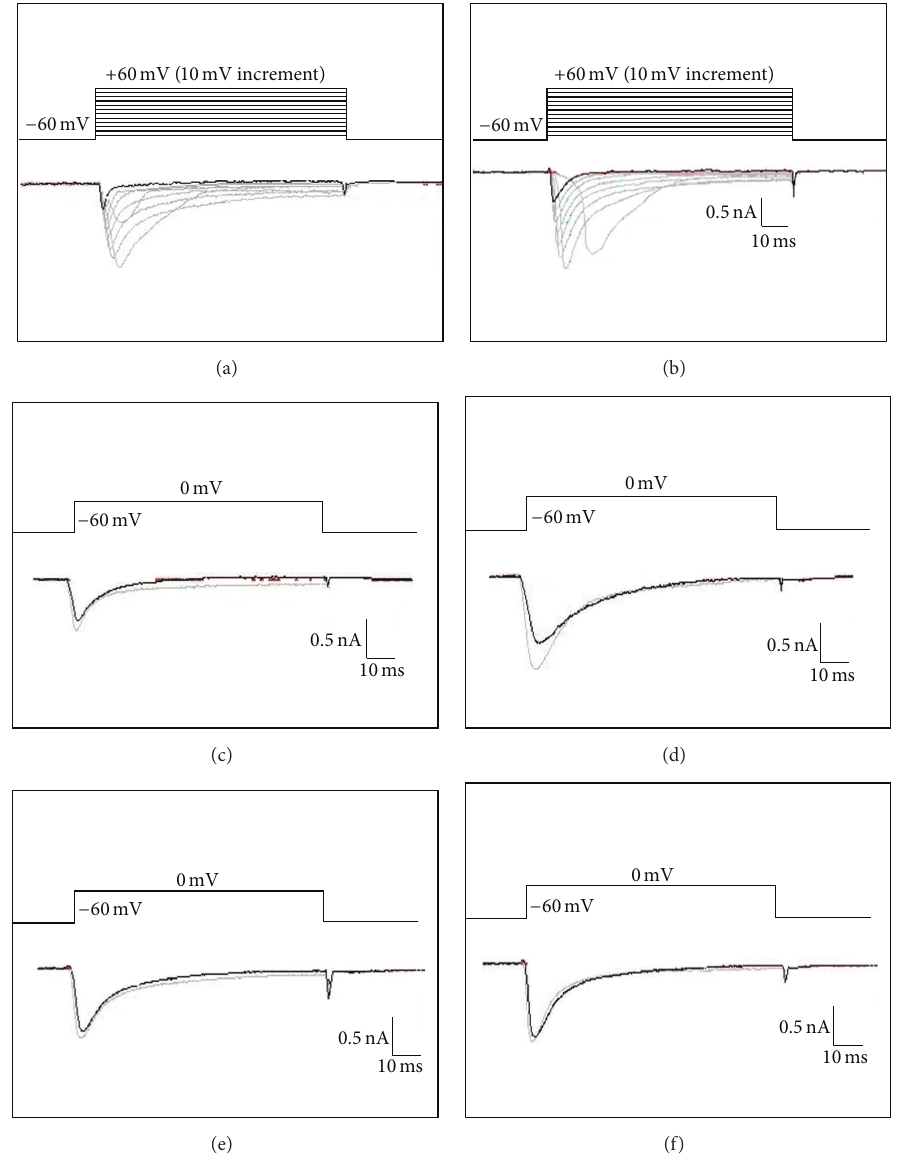
Figure 1: Representative traces of VGSCs. Cells were depolarized to a variety of membrane potentials ((a) 𝐼 Na ( V ) and (b) 𝐼 Na ( V 1.8) ). 𝐼 Na ( V ) currents before (black) and after (gray) application of 10pg R32W (c) and D145 (d). 𝐼 Na ( V 1.8) currents before (black) and after (gray) application of 100 pg R32W (e) and D145